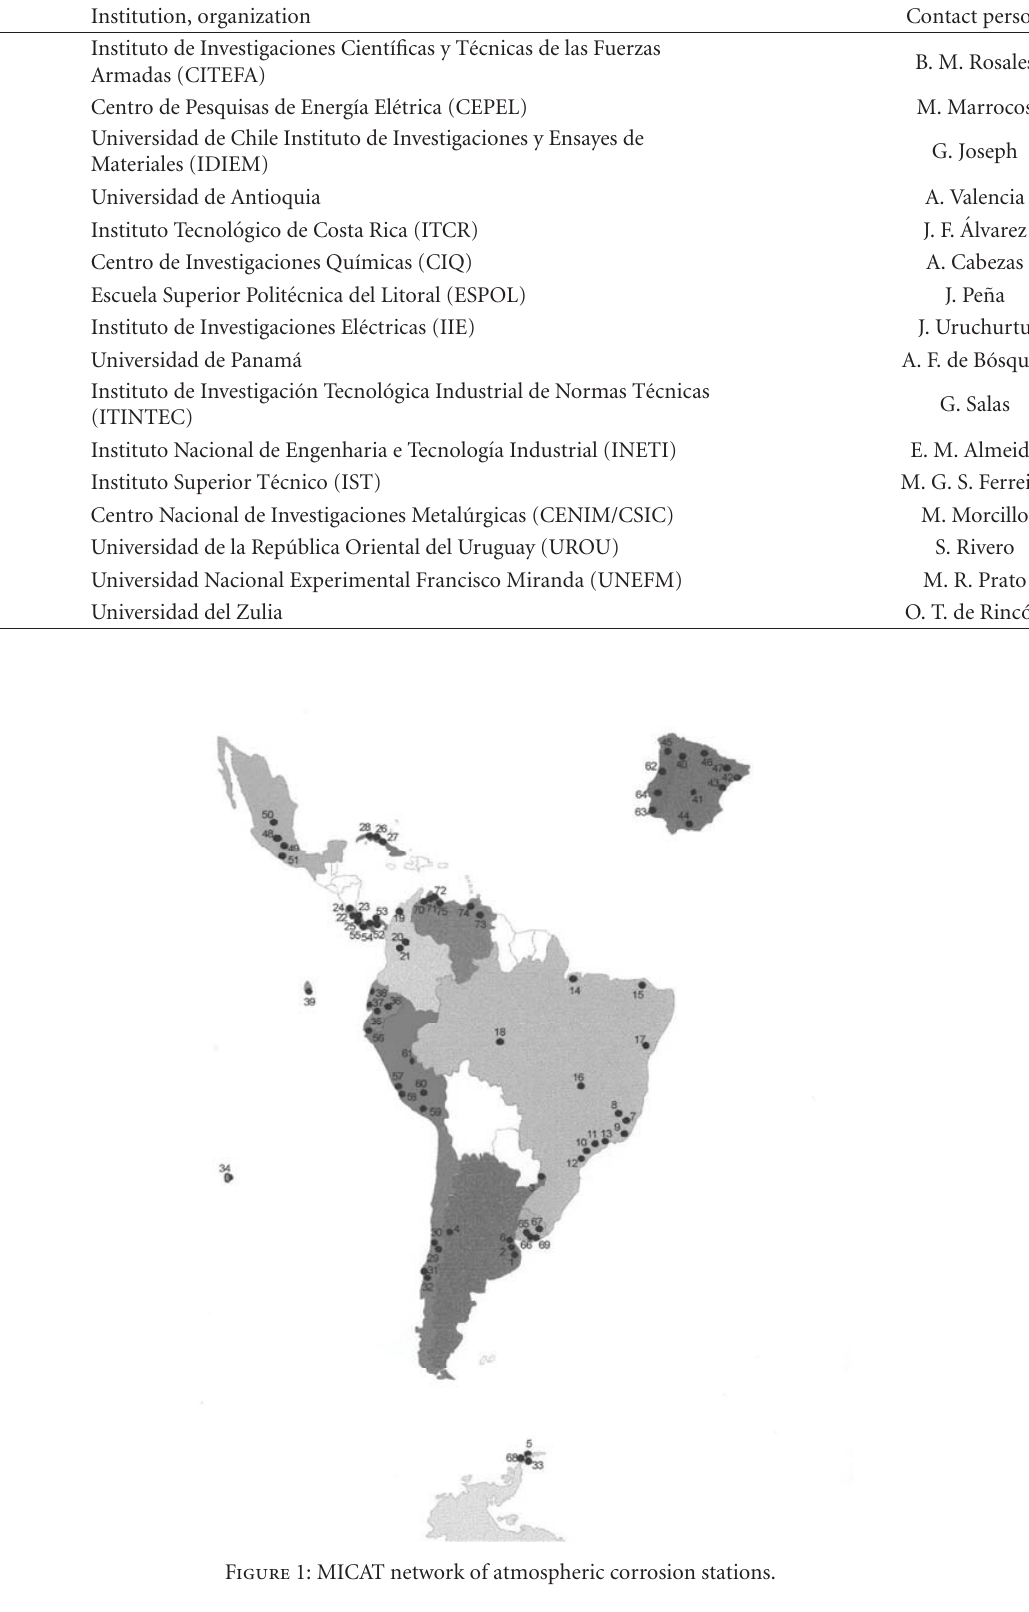
Table 1: Organizations participating in the MICAT Project.